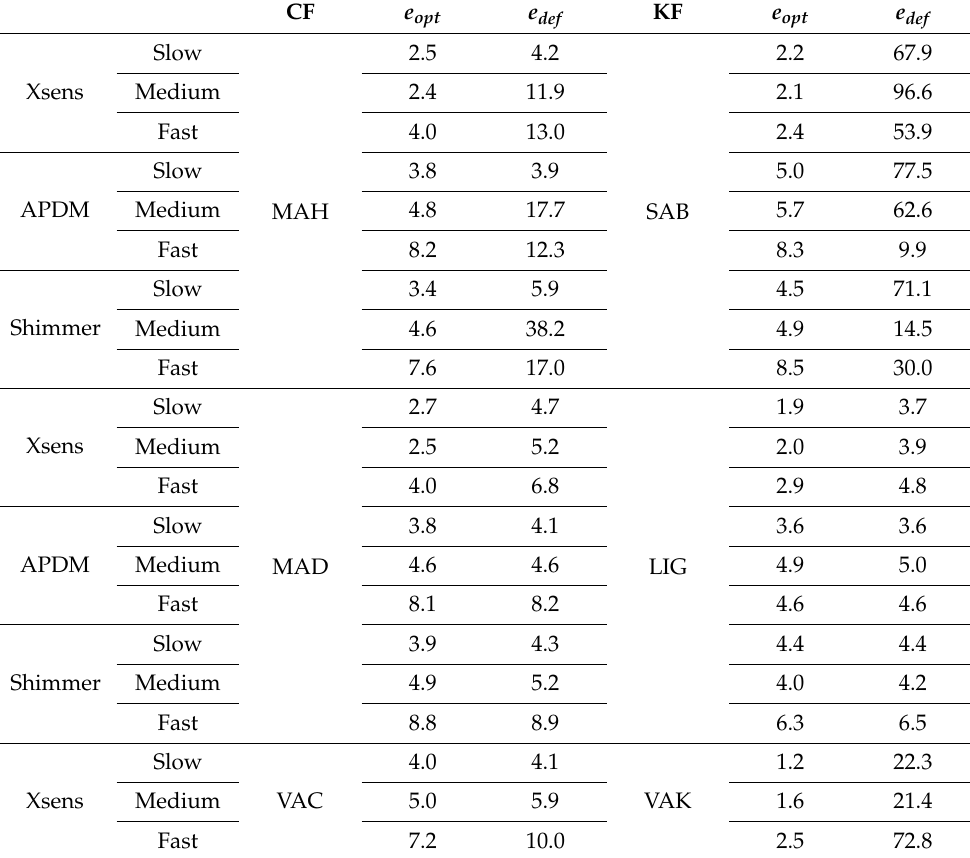
Table 3. The Optimal Errors Are Reported with the Absolute Errors Obtained Using the Default Parameter